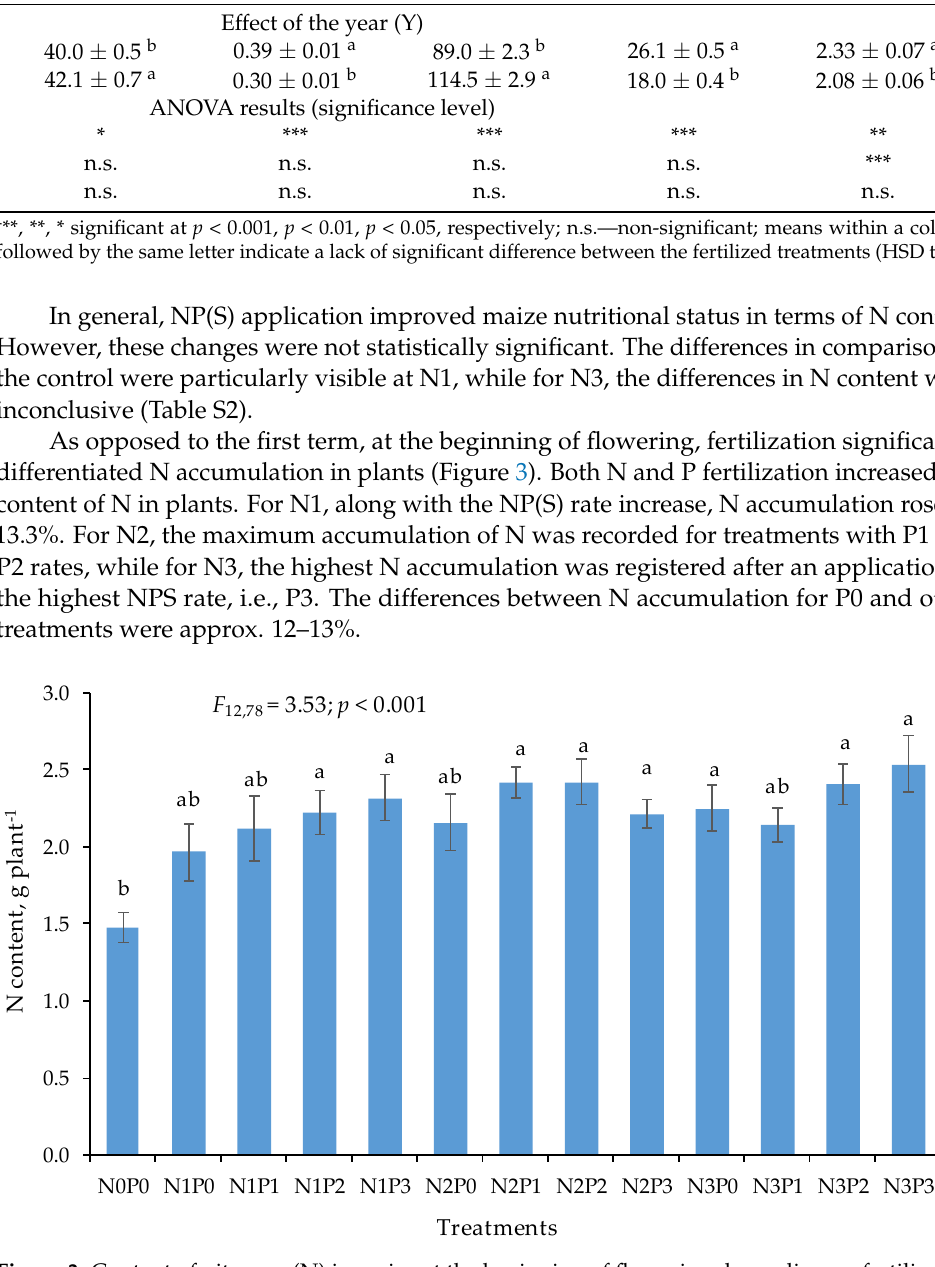
Figure 3. Content of nitrogen (N) in maize at the beginning of flowering depending on fertilization treatments. Two-year average values. Means within a column followed by the same letter indicate a lack of significant difference between the fertilized treatments (HSD test). Hatched bars represent 2 × SEM